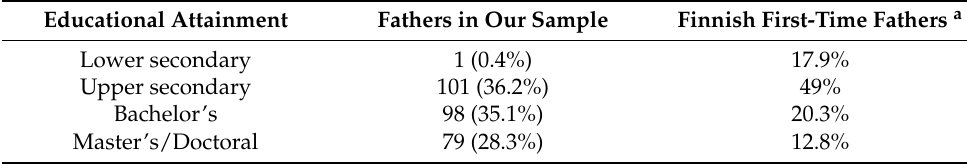
Table 2. Fathers’ Educational Level Compared to National Average.